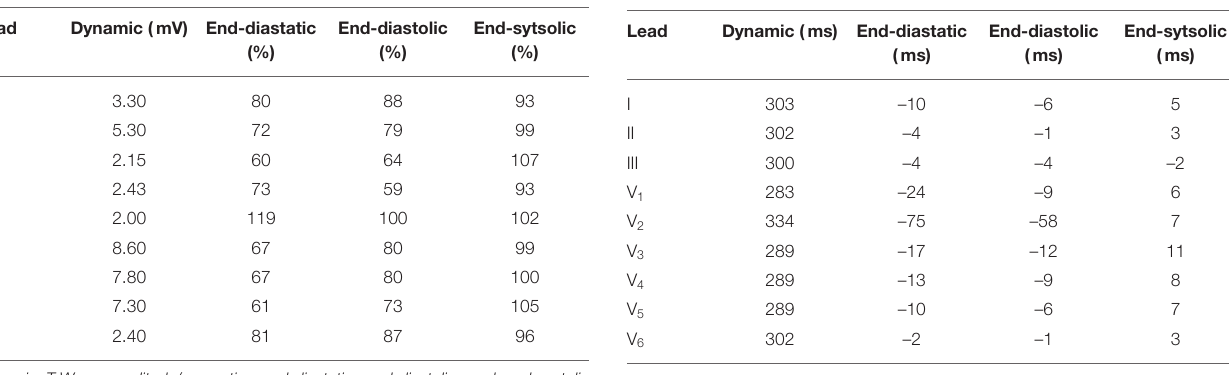
TABLE 2 | End of T-Wave (measured from earliest ventricular activation) in the dynamic configuration in the standard leads and differences of the three static cases in respect to the dynamic